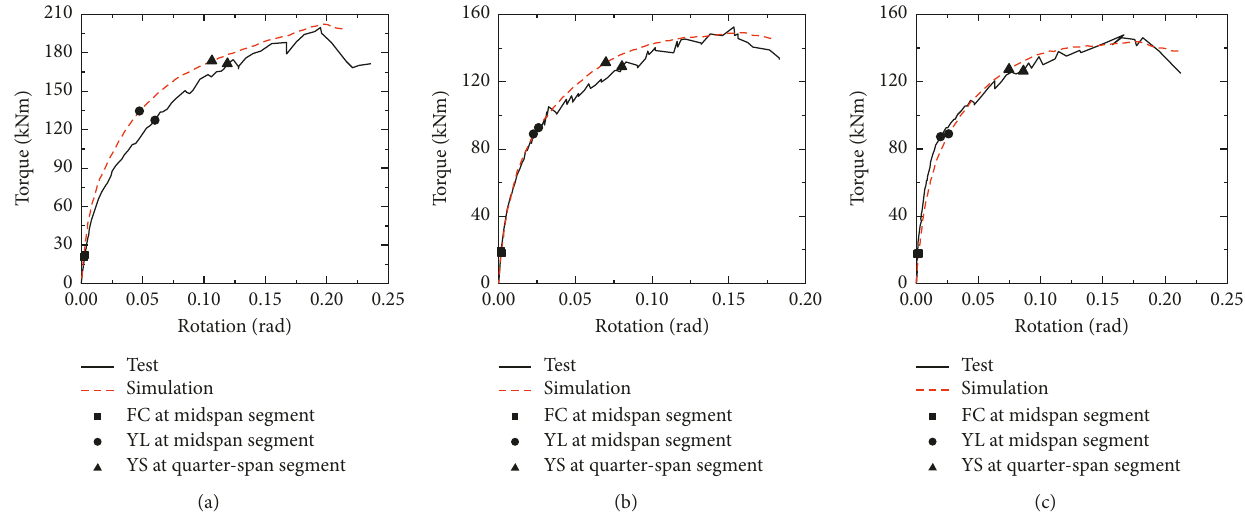
Figure 13: Simulated and tested torque-rotation curves: (a) MEM-1, (b) MEM-2, and (c)